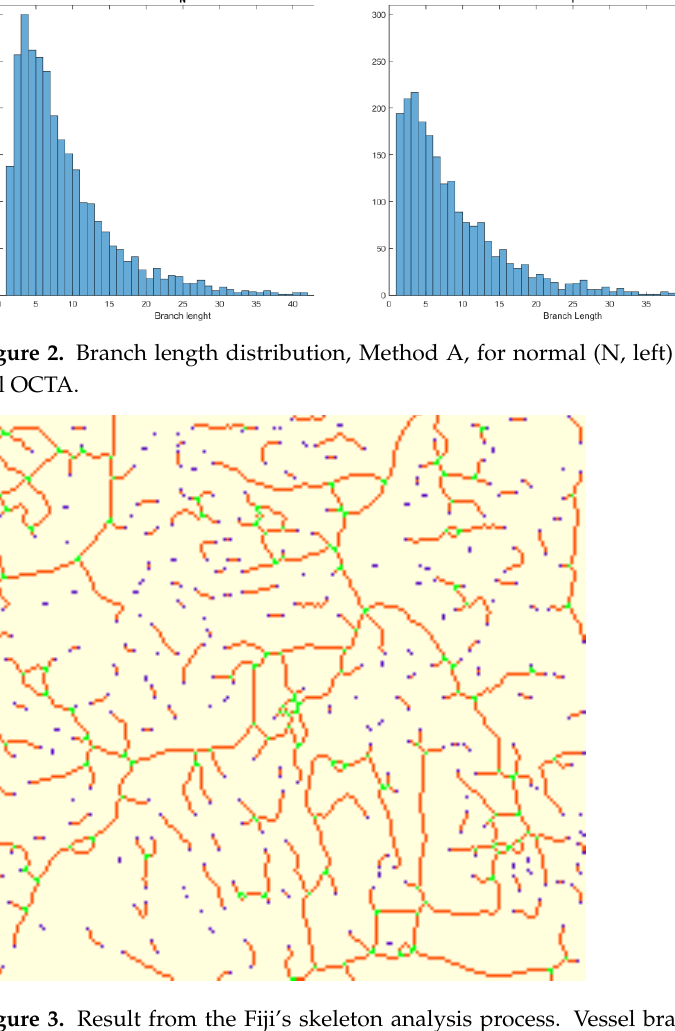
Figure 3. Result from the Fiji’s skeleton analysis process. Vessel branches are drawn in orange, separated by green junctions and terminated by blue end points.